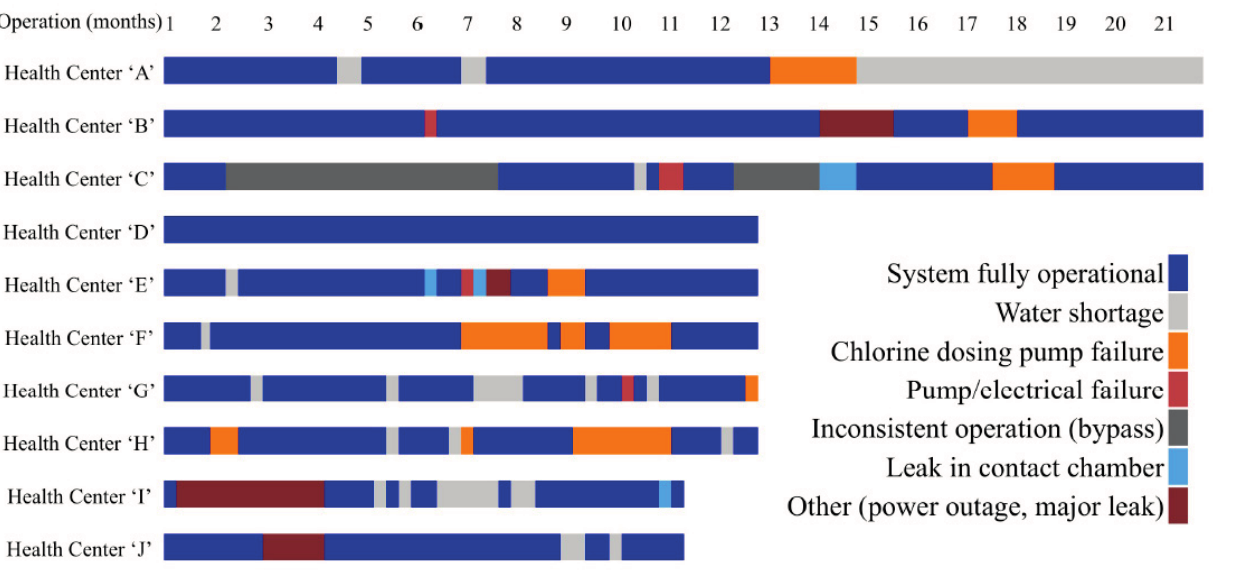
Figure 1. Event log timeline of water treatment system service interruptions and causes at ten health centers in rural Rwanda, March 2012–December